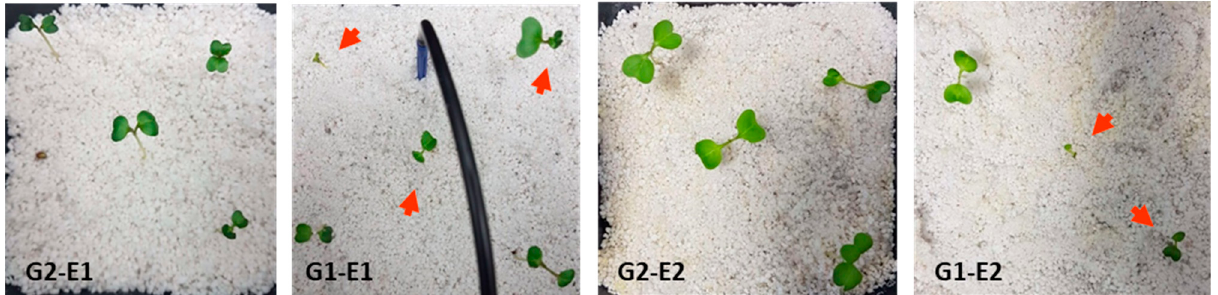
Figure 3. Radish seedlings from different groups (G) two weeks post sowing, in the two experimental setups (E). Phenotypic aberrations are indicated by red arrows.